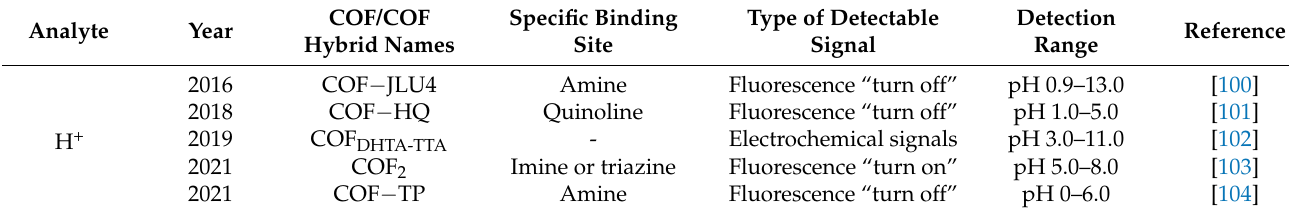
Table 4. COF-based pH sensing.